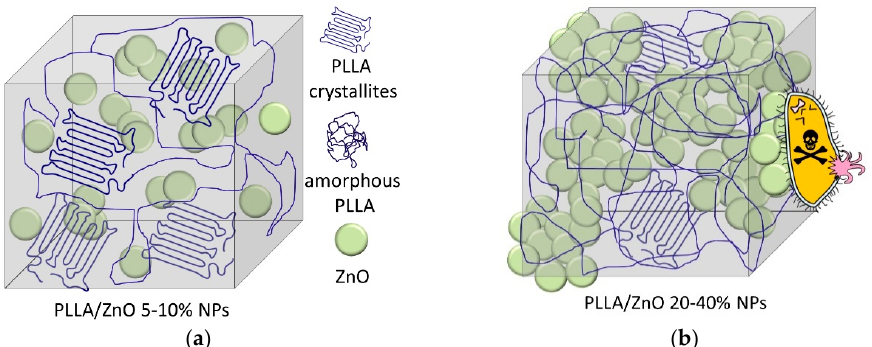
Figure 7. Schematic presentation of PLLA/ZnO membranes doped with smaller ( a ) and larger ( b ) amounts of ZnO NPs. ZnO NPs are distributed uniformly in the bulk of material presented in panel ( a ), while they were agglomerated and partially protrude on the surface of PLLA matrix in panel ( b ).